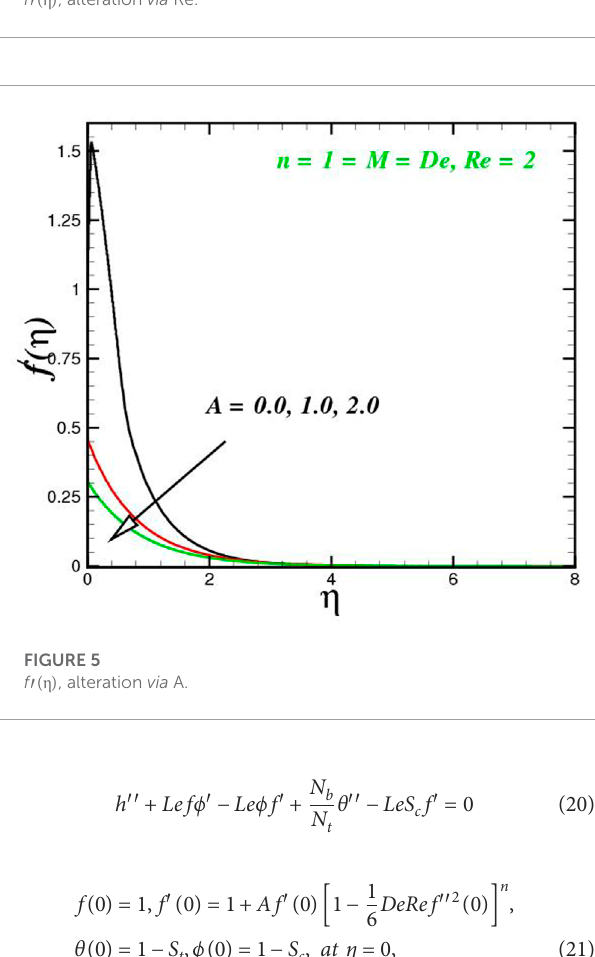
FIGURE 2 f ′( η ) , alteration via M.